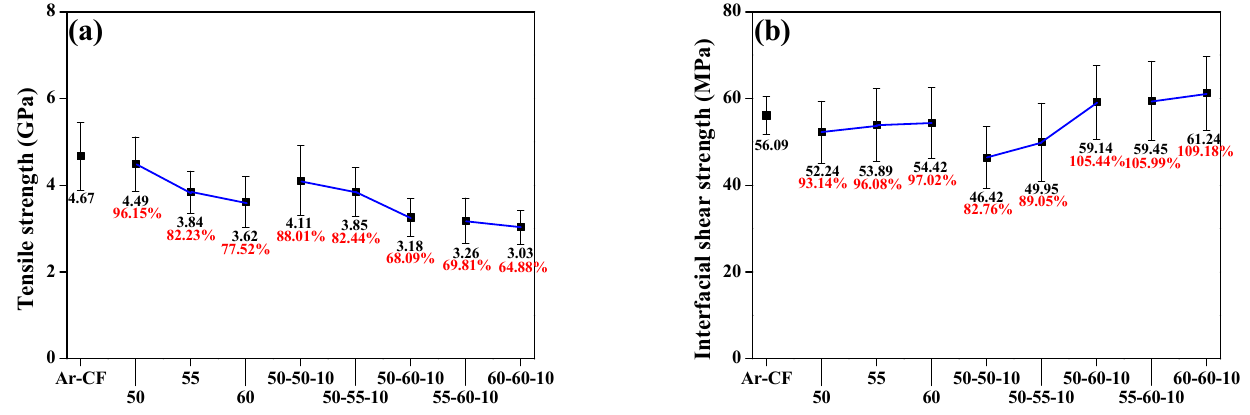
Figure 7. Physical properties of the as-received and recycled carbon fibers under varying pyrolysis conditions: ( a ) tensile strength and ( b ) interfacial shear strength.